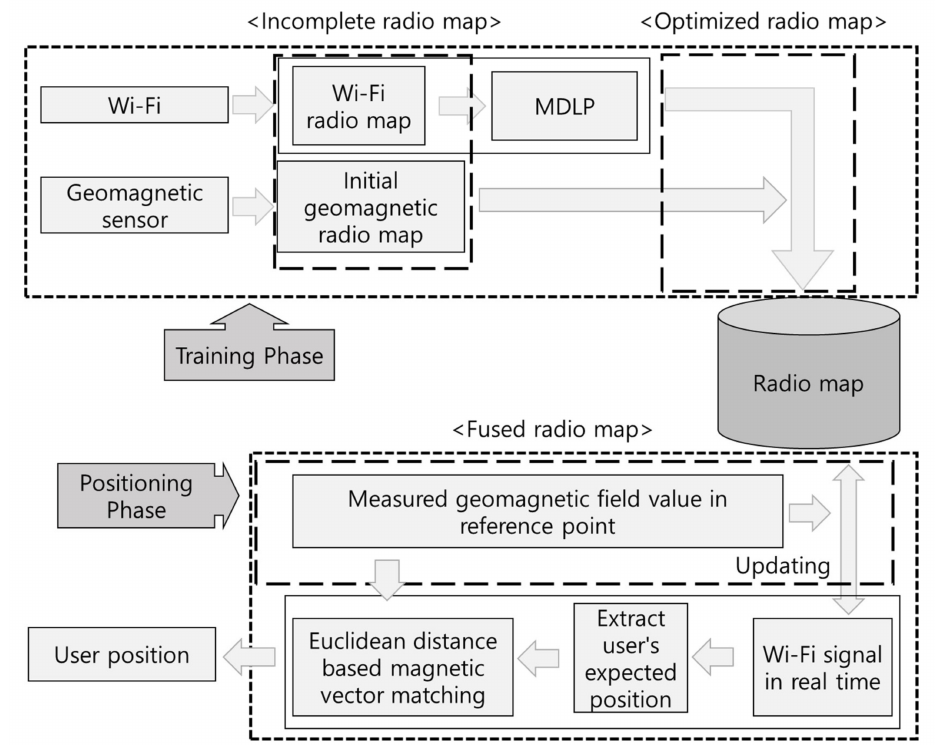
Figure 4. Proposed radio map structure based on Wi-Fi and